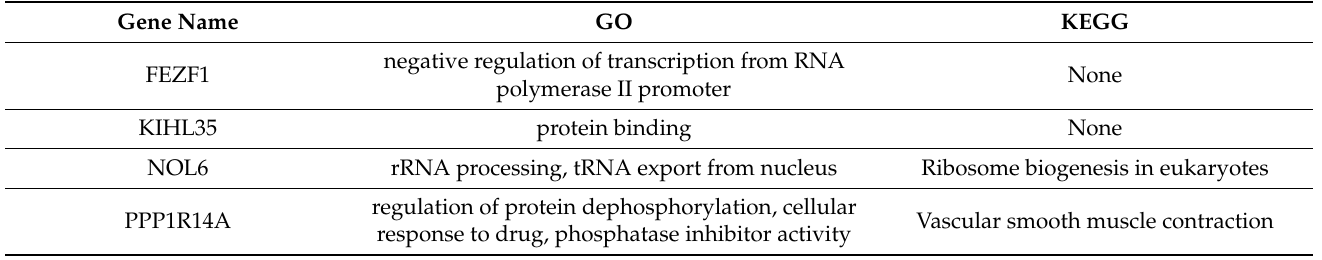
Table 1. GO and KEGG items of NOL6, FEZF1, PPP1R14A and KLHL35.